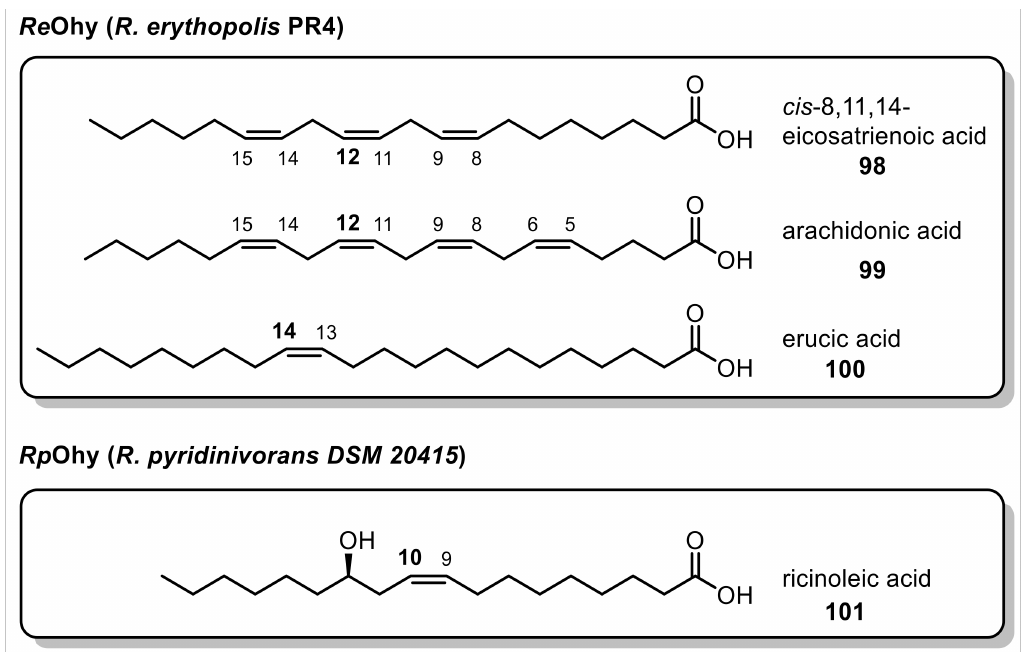
Figure 1. Exemplary display of complementary substrate scope of two Ohy from Rhodococcus . The bold number indicates the location of the hydroxy-group in the final hydrated